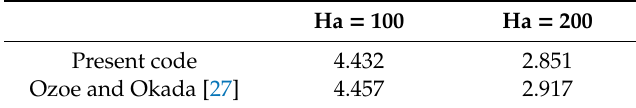
Table 3. Average Nusselt number for Ra = 10 6 , Pr = 0.054, and α = 0 ◦ : comparison with Ozoe and Okada